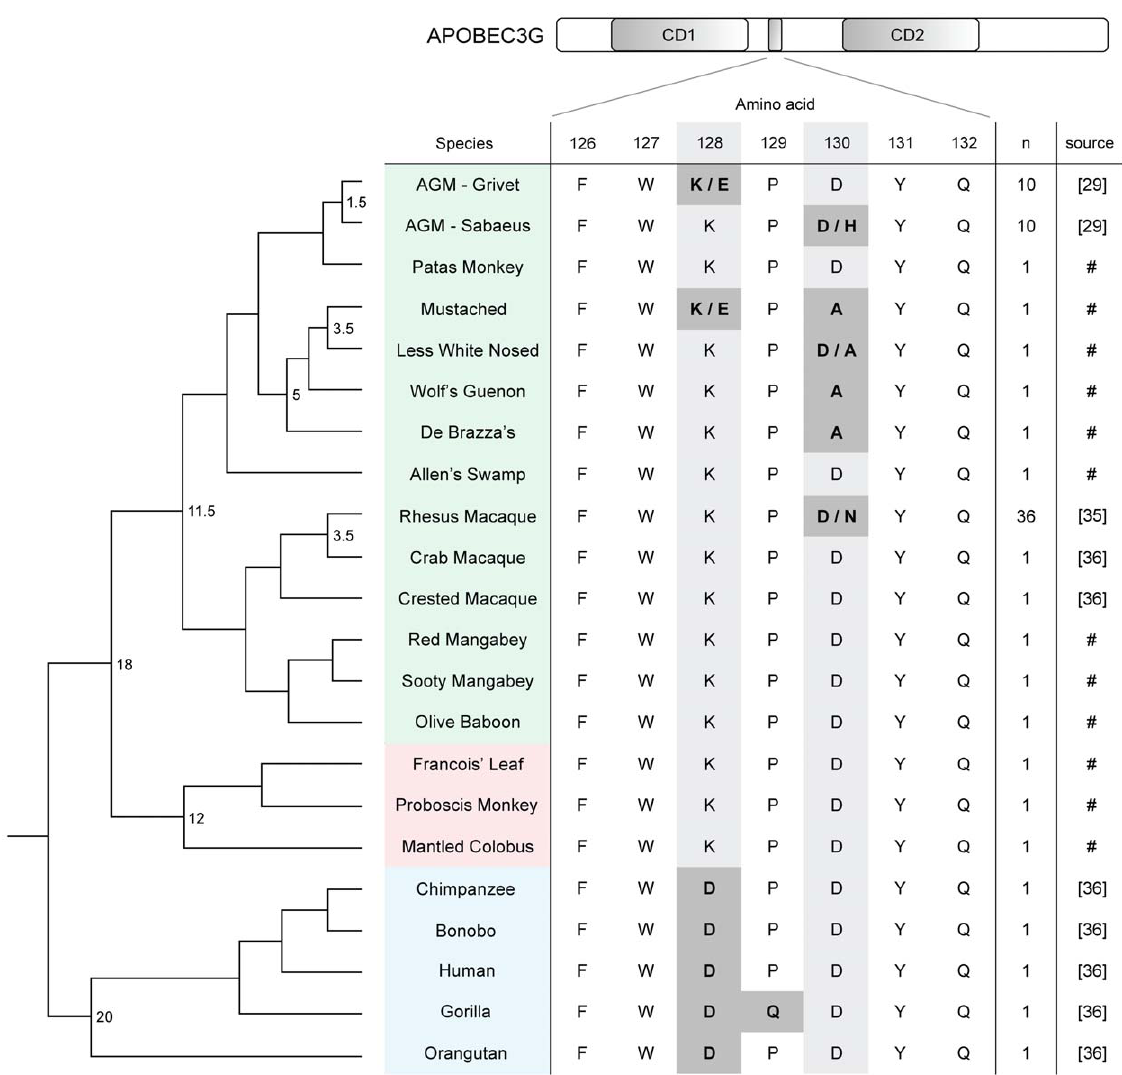
Figure 1. Diversifying selection of the Vif binding site of APOBEC3G in the Cercopithecinae subfamily of Old World Monkeys. A partial primate species phylogeny [37] is depicted as a cladogram and accompanied by partial amino acid sequences of respective A3G orthologs. Approximate divergence times (in millions of years) are placed at relevant ancestral nodes. Select residues comprising the putative site targeted by Vif proteins are shown. Primates of the order Catarrhini , consisting of hominoids (blue) and Old World Monkeys, are included. Old World Monkeys are subdivided into the Cercopithecinae (green) and Colobinae (red) subfamilies. Sources of sequences previously reported elsewhere are indicated by reference number. # =new sequences reported in this study, n=number of individuals analyzed per